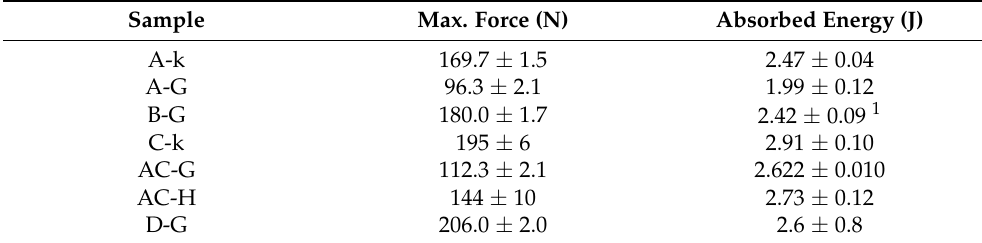
Table 2. Maximum forces and absorbed energies derived from Figures 1 and